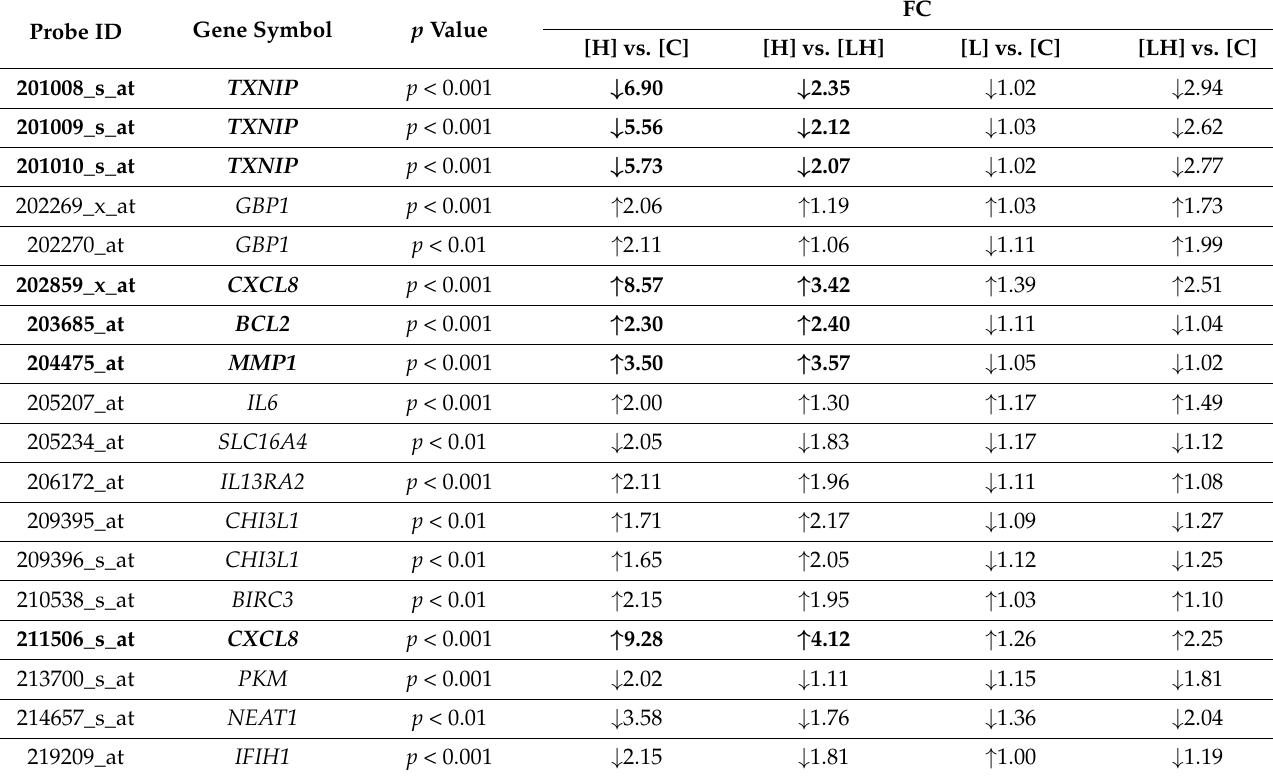
Table 3. Characteristics of pyroptosis-related genes, which had more than a two-fold statistically significant change in their expression in at least one